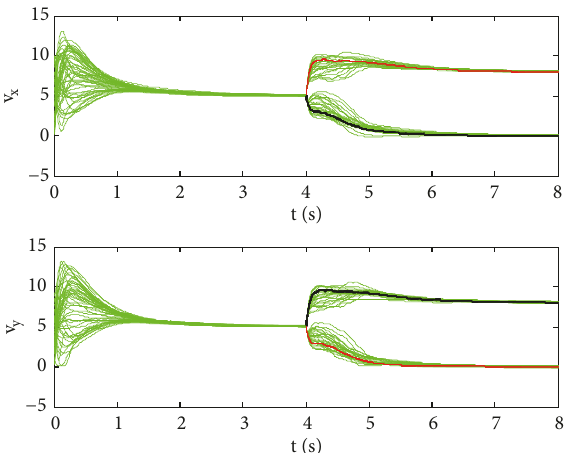
Figure 3: Velocities of individuals in the fusion-fission process.